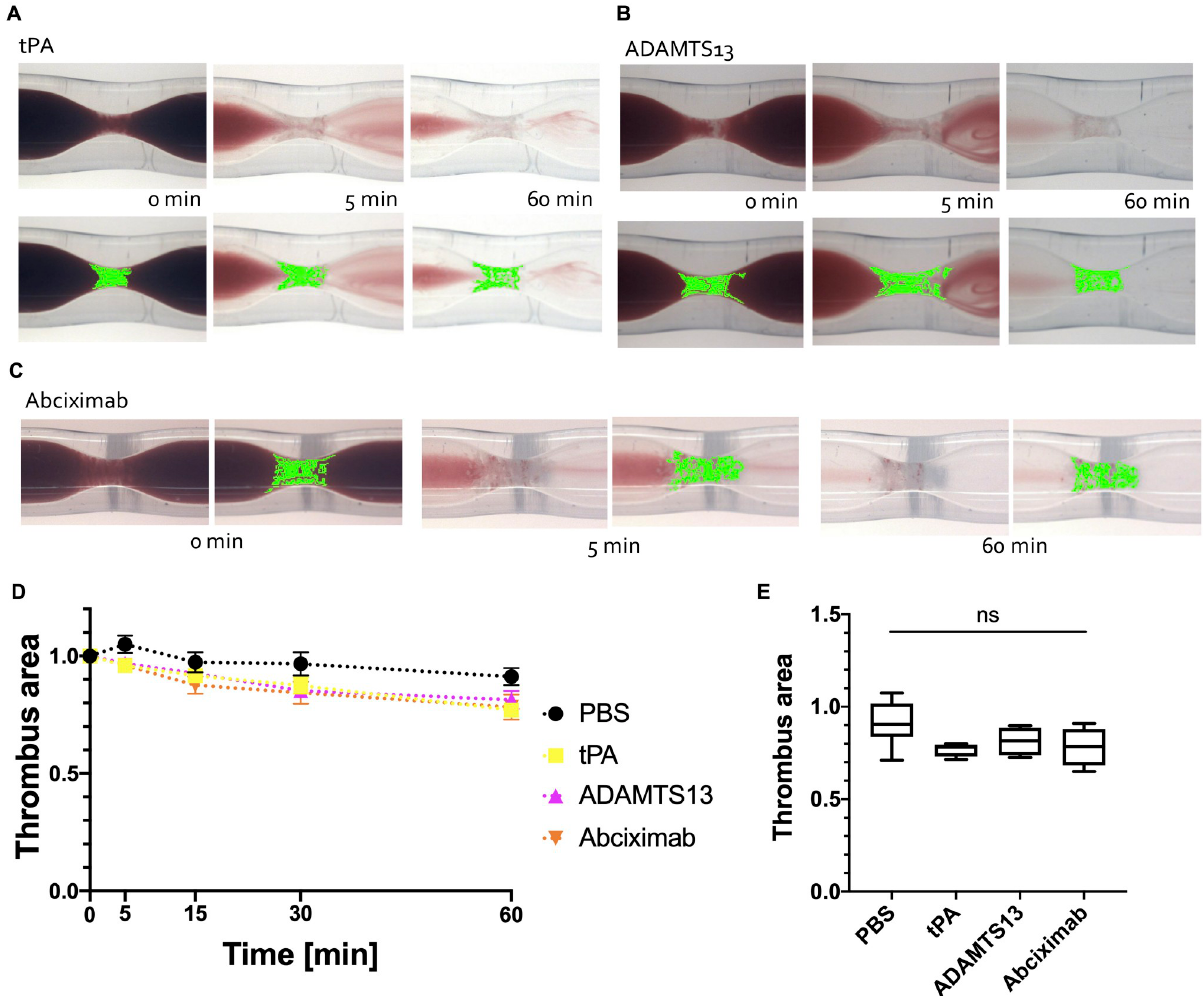
Fig 4. Thrombolysis with the other agents. Thrombus area is highlighted in green. A tPA, B ADAMTS-13, and C abciximab perfusion showed minimal lysis after 60 min. D Thrombus area reduction over time. E Thrombus area after 60 min perfusion with the indicated agent (x-axis). Perfusion of tPA, ADAMTS-13, and abciximab had no effect on white clot, with no differences from the